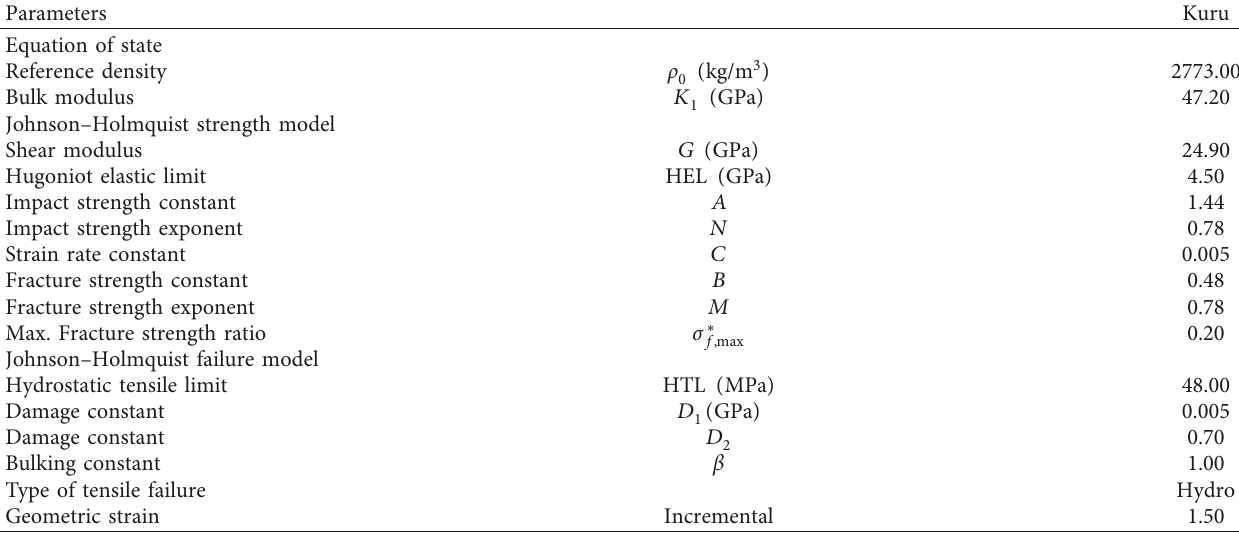
Table 1: Mechanical parameters of granite used in